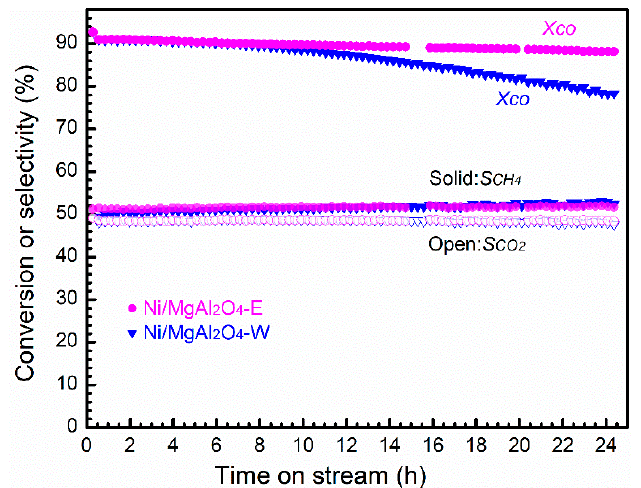
Figure 5. The stability results of the Ni/MgAl 2 O 4 -W and Ni/MgAl 2 O 4 -E catalysts in dry methanation reaction at 450 °C and GHSV of 10,000 mL h − 1 g cat. − 1 .